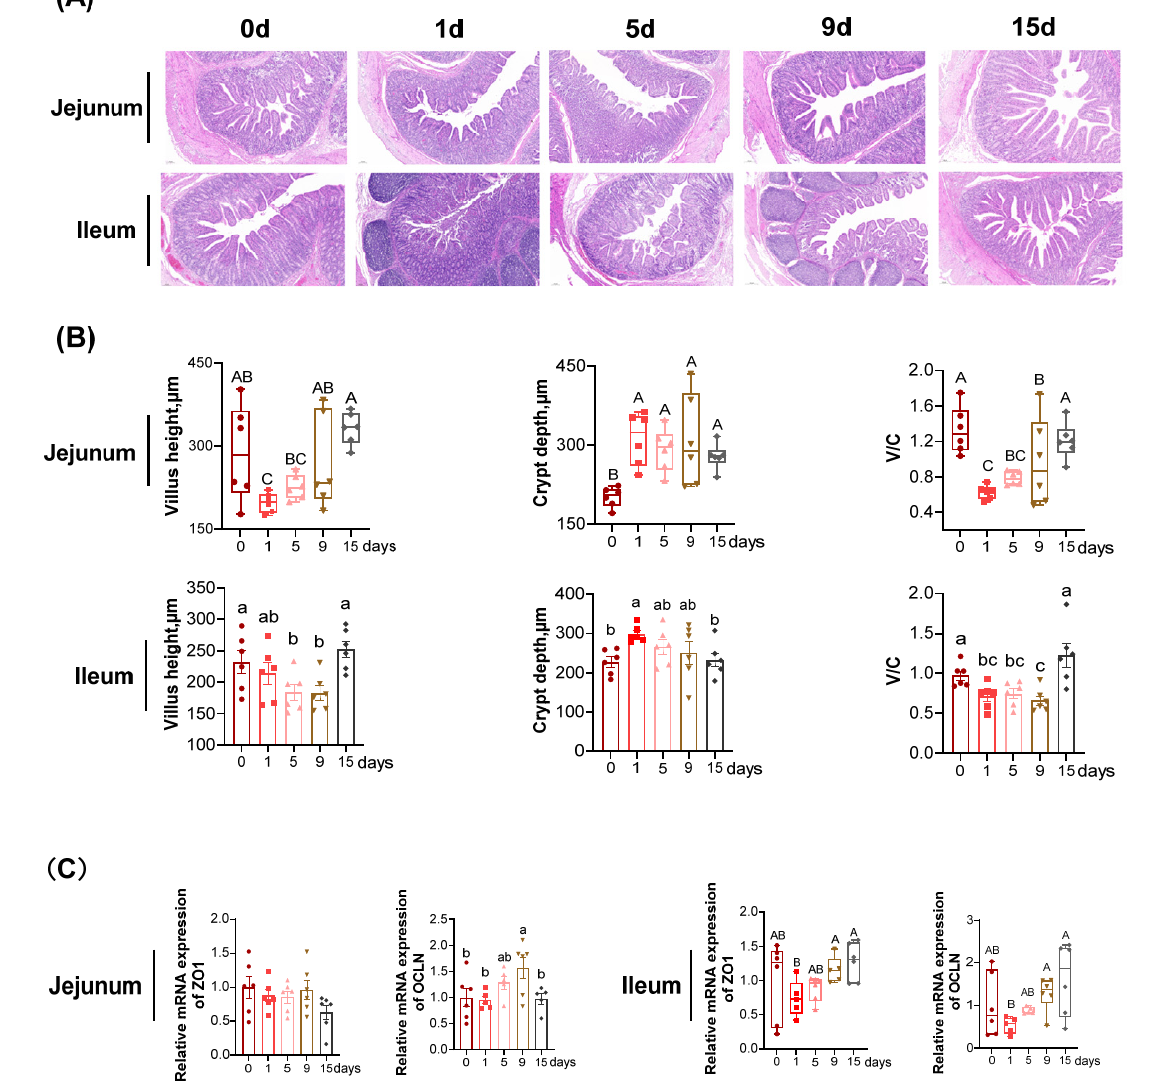
Figure 2. The intestinal mucosa barrier function under LPS-induced chronic immune stress: ( A ) representative hematoxylin-eosin stained image of intestine (magnification 10 × ); ( B ) quantification analysis of intestinal villus height, crypt depth, and ratio of villus height to crypt depth (V/C); ( C ) gene expression of tight junction proteins in intestinal mucosa. The two end edges of the box correspond to inter quartile ranges of data, the inside line represents the median, and the colored dot, squared, regular triangle, inverted triangle and diamond block in the figure correspond to the outliers for different days. n = 6 for each group. a,b,c Values within a row with different lowercase letters differ significantly ( p < 0.05) by the Duncan’s multiple comparisons. A,B,C Values within a row with different capital letters differ significantly ( p < 0.05) by the Kruskal–Wallis test. ZO1,